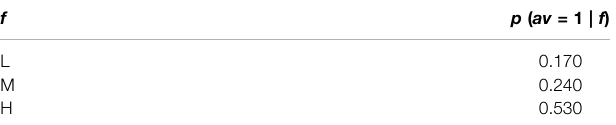
TABLE 2 | Main elements of the POMDP model for the collision avoidance problem. Angular velocity model p ( av | f ).